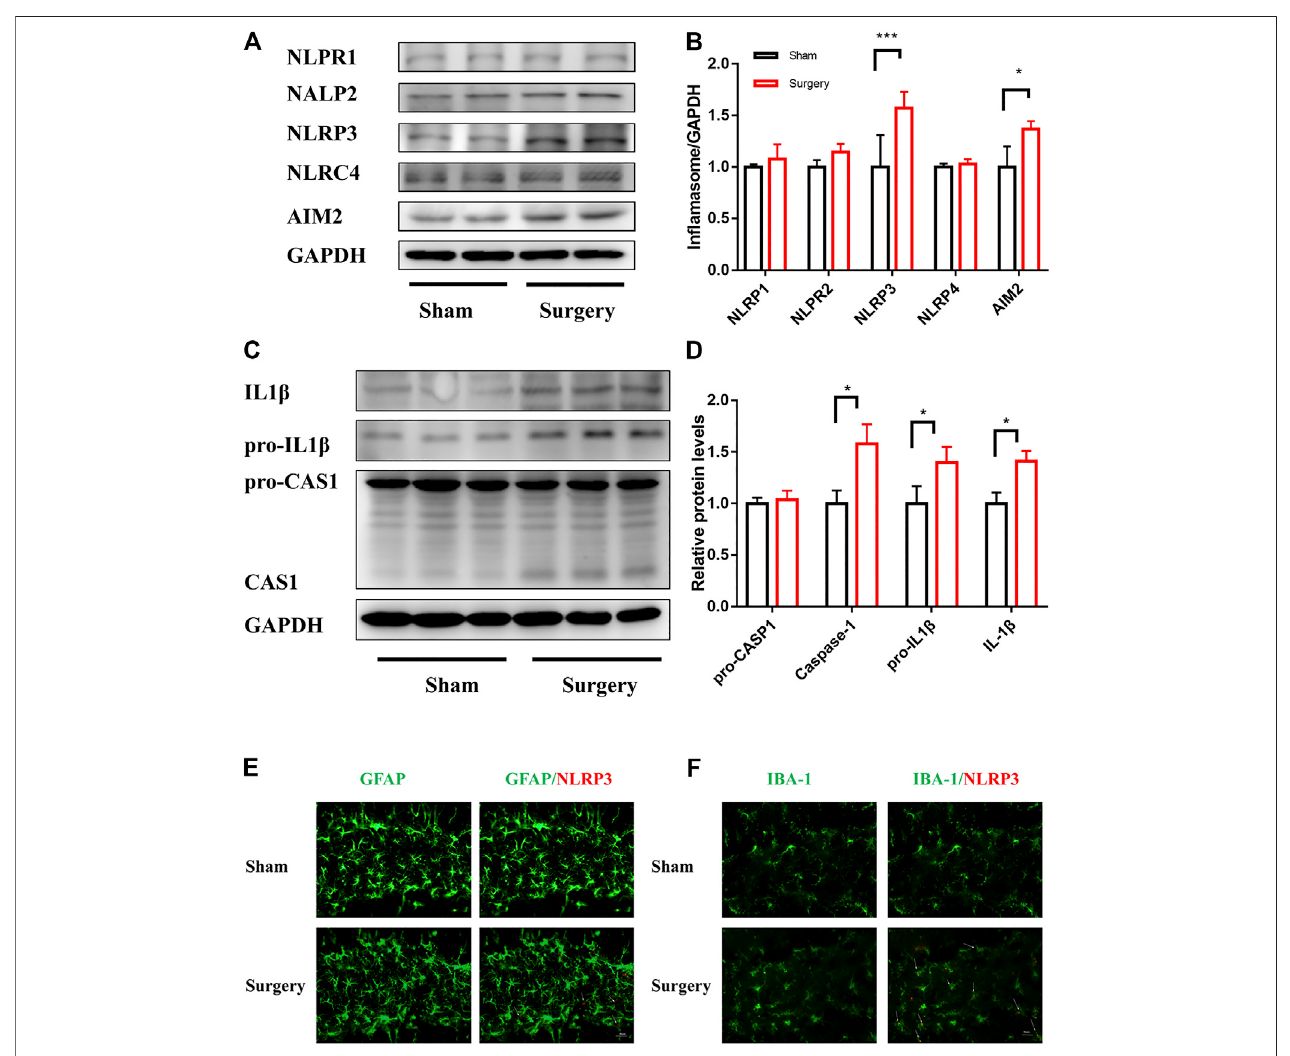
FIGURE 1| NLRP3 activation in microglia wasassociated with surgery-induced in fl ammation. NLRP3 activation in microglia was associated with surgery-induced in fl ammation. (A) : The expression levels of NLRP1, AIM2, NLRP2, NLRP3, and NLRC4 in the hippocampus were examined by Immunoblotting, and the statistical data are shown in (B) (means ± SEM, n (cid:1) 3). (C) : pro-IL1 β /IL1 β ,pro-CASP1/CASP1/CASPASE1 protein expression in the hippocampus were measured by Immunoblotting and the quantitative analysis data shown in (D) (means ± SEM, n (cid:1) 3). (E,F) Immuno fl uorescence staining of IBA-1, GFAP and NLRP3 in the hippocampal dentategyrus brain region. * p < 0.05, ** p < 0.01, *** p < 0.001 compared with the corresponding sham group, as determined by the Student ’ s t